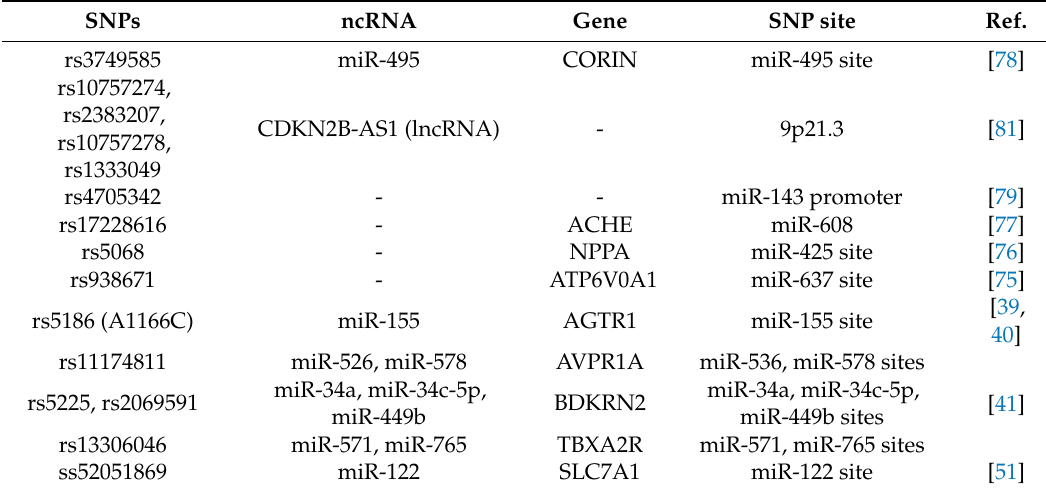
Table 2. SNPs associated with